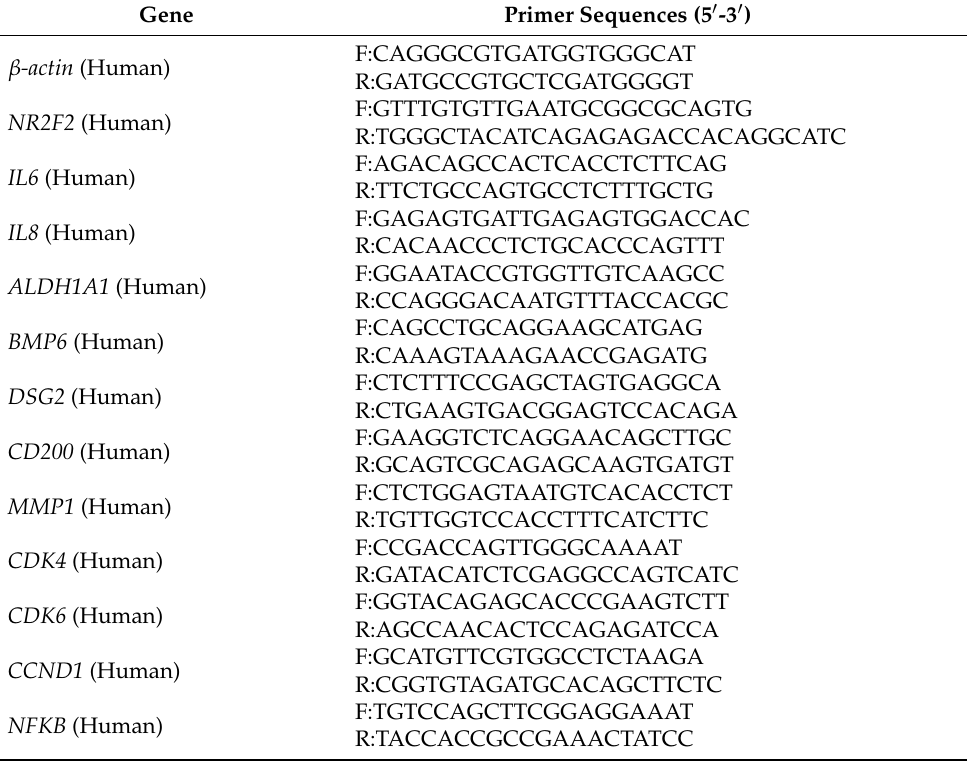
Table 1. Primer sequences of target genes in qPCR. Gene Primer Sequences (5 (cid:48) -3 (cid:48)